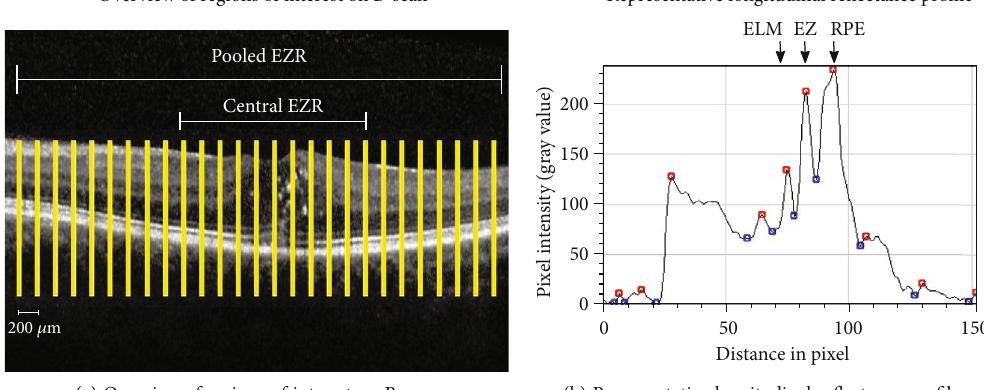
Figure 1: (a) Overview of regions of interest (ROI). In total, 27 measurements in 200 μ m distance of each OCT B-scan were obtained and analyzed. (b) shows a representative longitudinal re fl ectance pro fi le at each ROI. Pixel intensity values ranged from 0 (black) to 255 (white) on gray scale. Maxima values ( “ peaks ” ) are represented by red dots and minima values between the peaks that are represented by blue